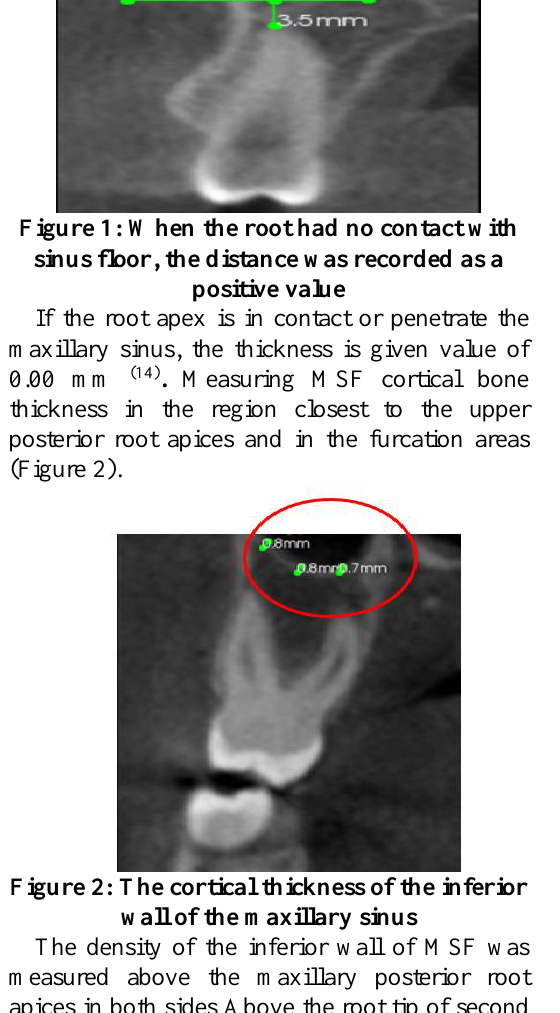
Figure 2: The cortical thickness of the inferior wall of the maxillary sinus